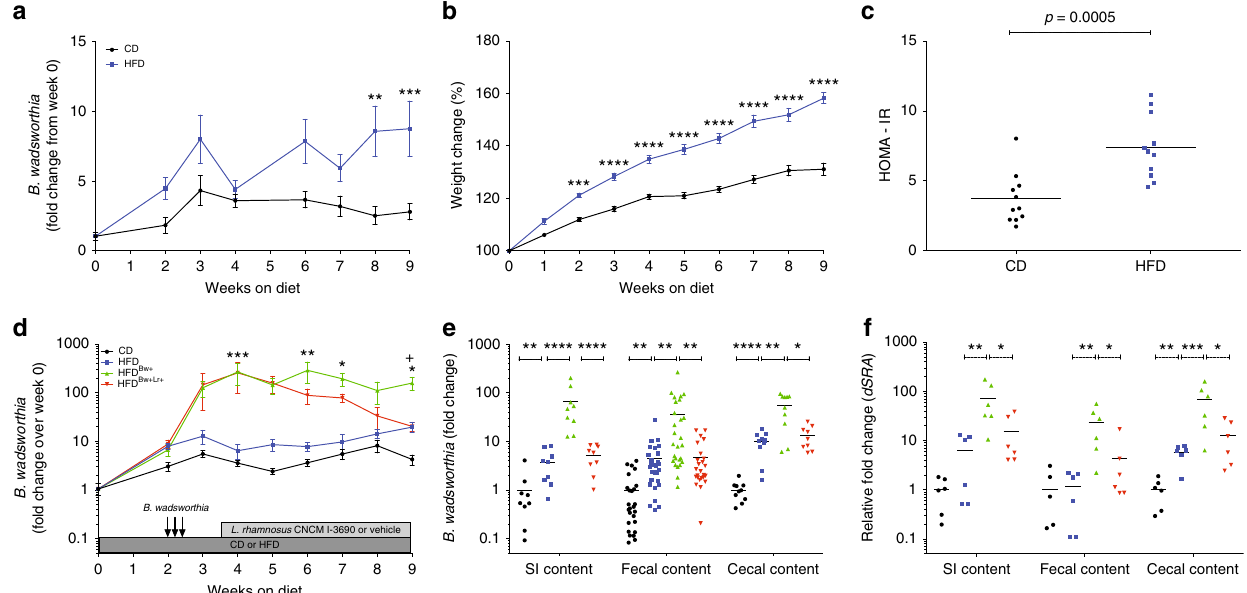
Fig. 1 B. wadsworthia expands in HFD environment. a Fold change of B. wadsworthia in mice fed with control diet (CD) or high-fat diet (HFD) relative from day 0 (** p < 0.01, *** p < 0.001; n = 11/group). b Body weight gain (*** p < 0.001, **** p < 0.0001; n = 11/group), c Homeostatic model assessment-insulin resistance (HOMA-IR) after 6 h of fasting ( n = 10/group). d Fold change of B. wadsworthia relative from day 0 in mice fed with control diet (CD) or high-fat diet (HFD) and inoculated with B. wadsworthia (Bw + ) and treated with L. rhamnosus CNCM I-3690 (Lr + ) (* p < 0.05, ** p < 0.01, *** p < 0.001 vs HFD; + p < 0.05 vs HFD Bw + Lr + ; n = 16 – 28/group). e B. wadsworthia load in small intestinal (SI), fecal and cecal contents after 9 weeks of CD or HFD. f Expression